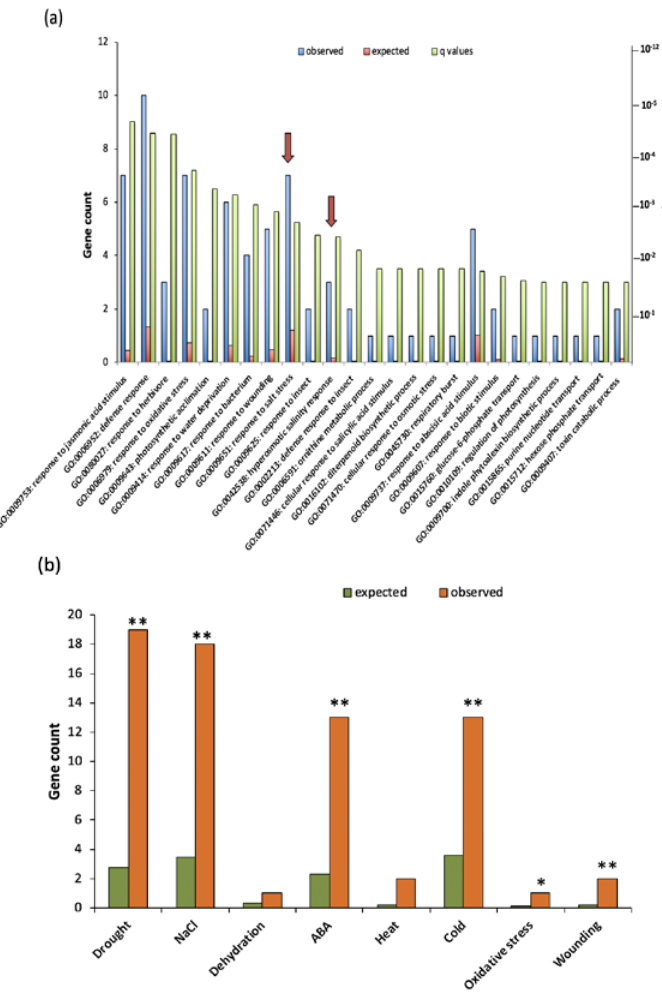
Figure 6. Gene ontology (GO) enrichment analysis of DE genes. ( a ) GO term enrichment analysis for biological processes of up-regulated genes. For each GO term, the expected and observed gene numbers along with the statistical significance ( p -value) for the enrichment is presented. Observed: Number of DE genes associated with a GO term for biological processes. Expected: Number of genes expected for each GO term in the genome. “Response to salt stress” and “Hyperosmotic salinity response” GO terms are indicated with an arrow. ( b ) A significant number of DE genes are associated with abiotic stress response in comparison with genome background with a ** p ≤ 0.0001 and * p ≤